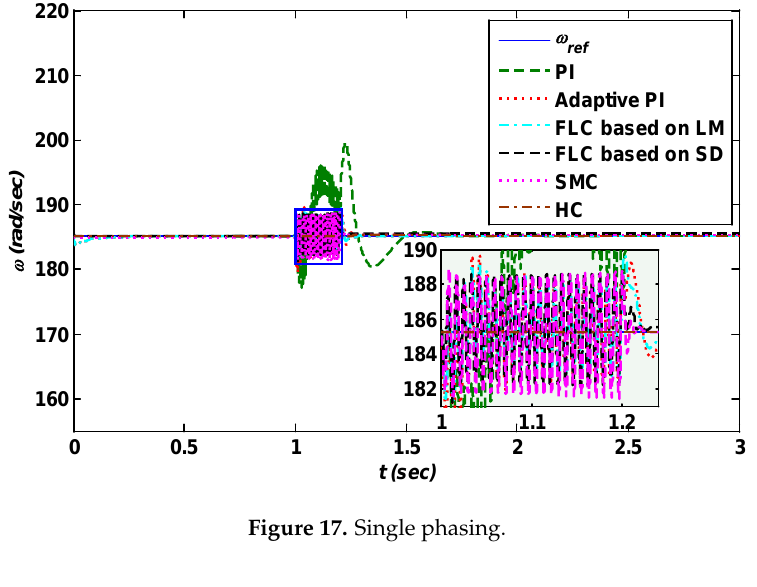
Figure 17. Single phasing.